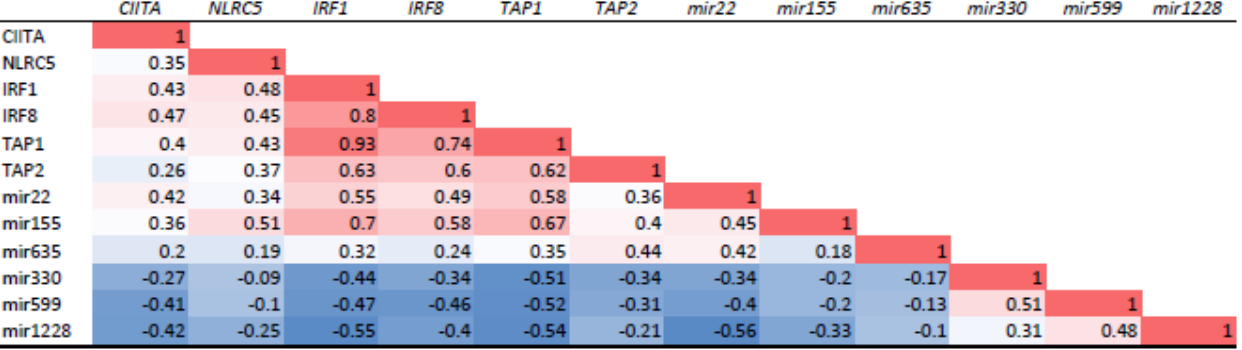
Figure 6. Correlation coefficients of the relation between several miRNAs and regulators of HLA expression and of members of the Antigen-Loading Machinery in the Leiden cohort. The expression of three miRNAs (miR-22, 155, 635) that are positively associated with HLA expression and of three (miR-330, 599, 1228) that are negatively associated with HLA expression were compared to Class I Regulatory Factors and members of the Antigen-Loading Machinery. The correlation coefficients based on Spearman correlations ( n = 64) are shown. The intensity of colors indicates the strength of the correlation, with red indicating positive and blue negative correlations.